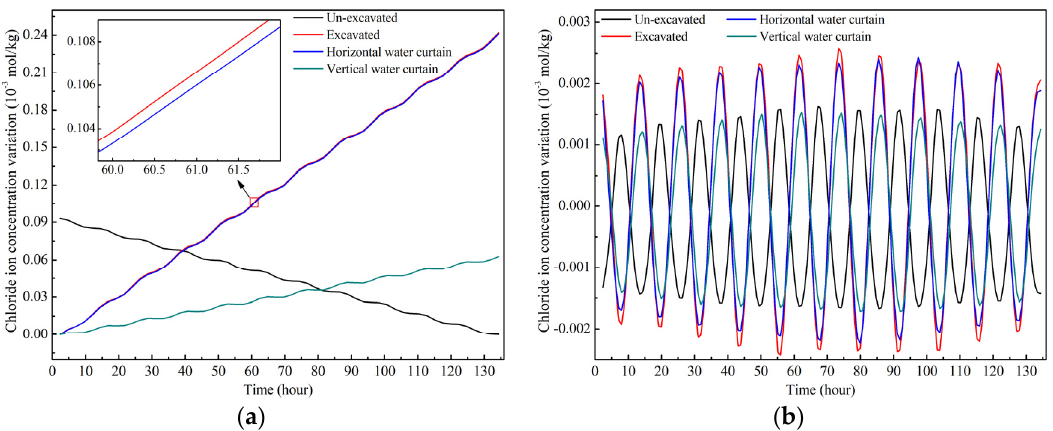
Figure 17. Chloride concentration curve: ( a ) chloride concentration varies over time; ( b ) chloride concentration fluctuation.